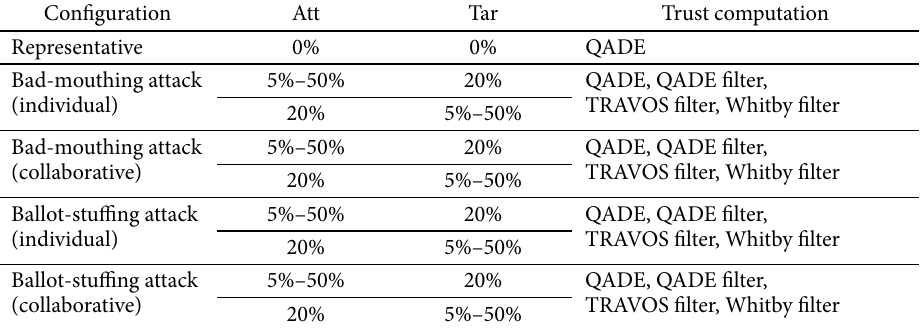
Table 3. Percentage of attackers and targeted agents in conducted